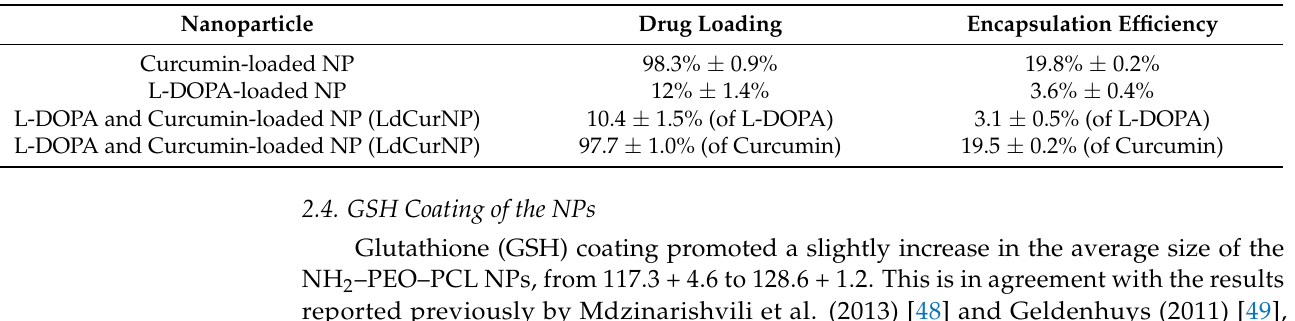
Table 2. Drug loading and encapsulation efficiency of NH 2 –PEO–PCL NPs loaded with curcumin, L-DOPA, or